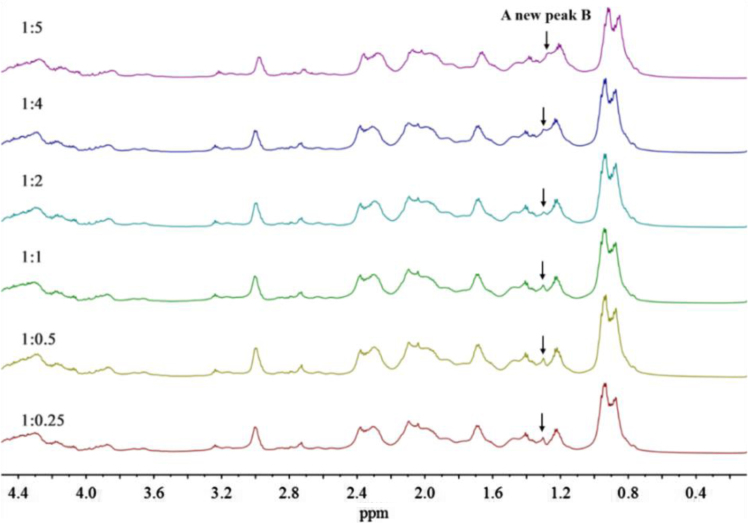
Stacked 1H NMR spectra of C16-caseinate.